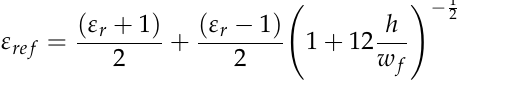
Table 3. Antenna designs and their respective variations.